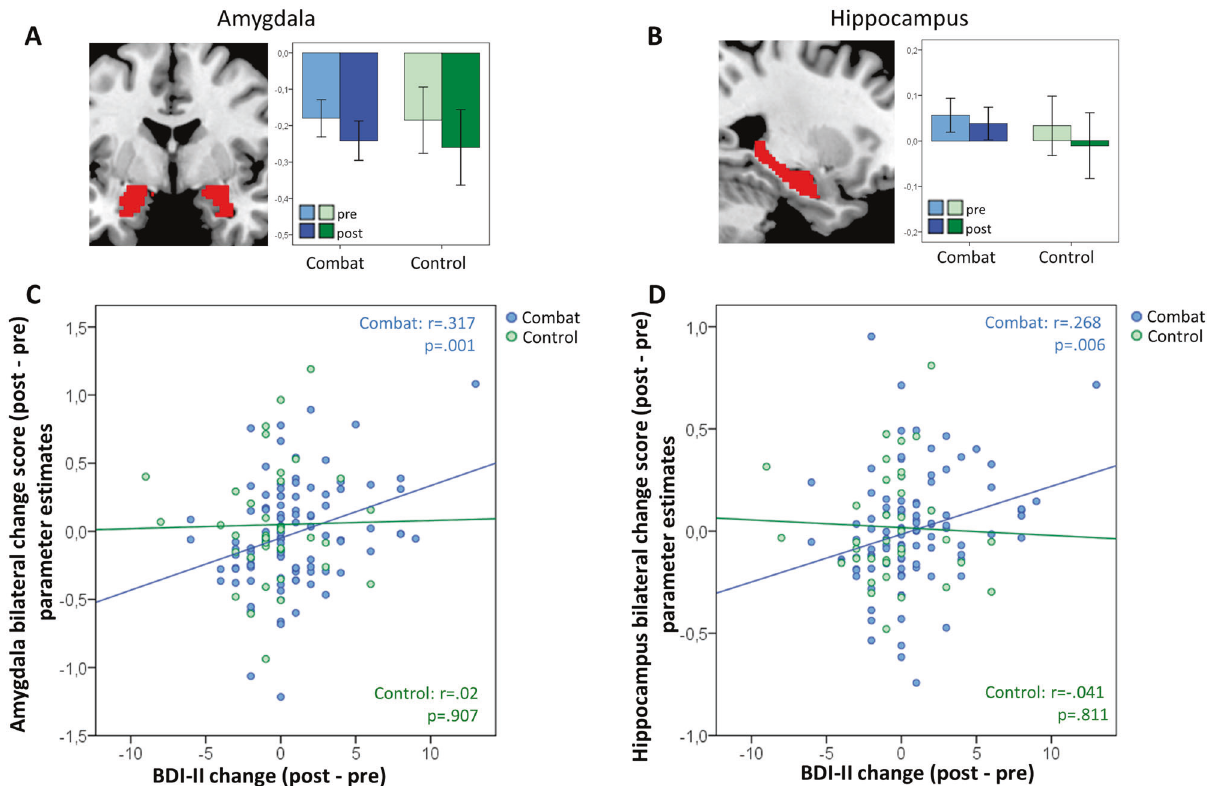
Fig. 3 Imaging results, region of interest (ROI) analysis, and correlational analyses. A , B Anatomical location and bar graphs for the contrast combat versus negative affective IAPS stimuli for the two groups and time points were presented for the two a priori de fi ned ROIs amygdala and hippocampus. In both regions no signi fi cant group (combat vs. control group) by time (pretest versus posttest) interactions were observed. Error bars in the bar graphs represent 95% con fi dence intervals. Results of other ROIs are shown in the supplementary material. C , D Associations of the change score of the ROI analyses and the behavioral analyses. On the x -axis the change of MDD symptom scores (posttest versus pretest) and on the y -axis the results from the ROIs of the ( C ) bilateral amygdala and the ( D ) bilateral hippocampus of the fMRI analysis using the interaction contrast posttest[combat > IAPS] > pretest[combat > IAPS] are shown. In both ROIs a signi fi cant correlation was observed in the combat group (shown in blue), but not in the control group (shown in green). For display purposes results